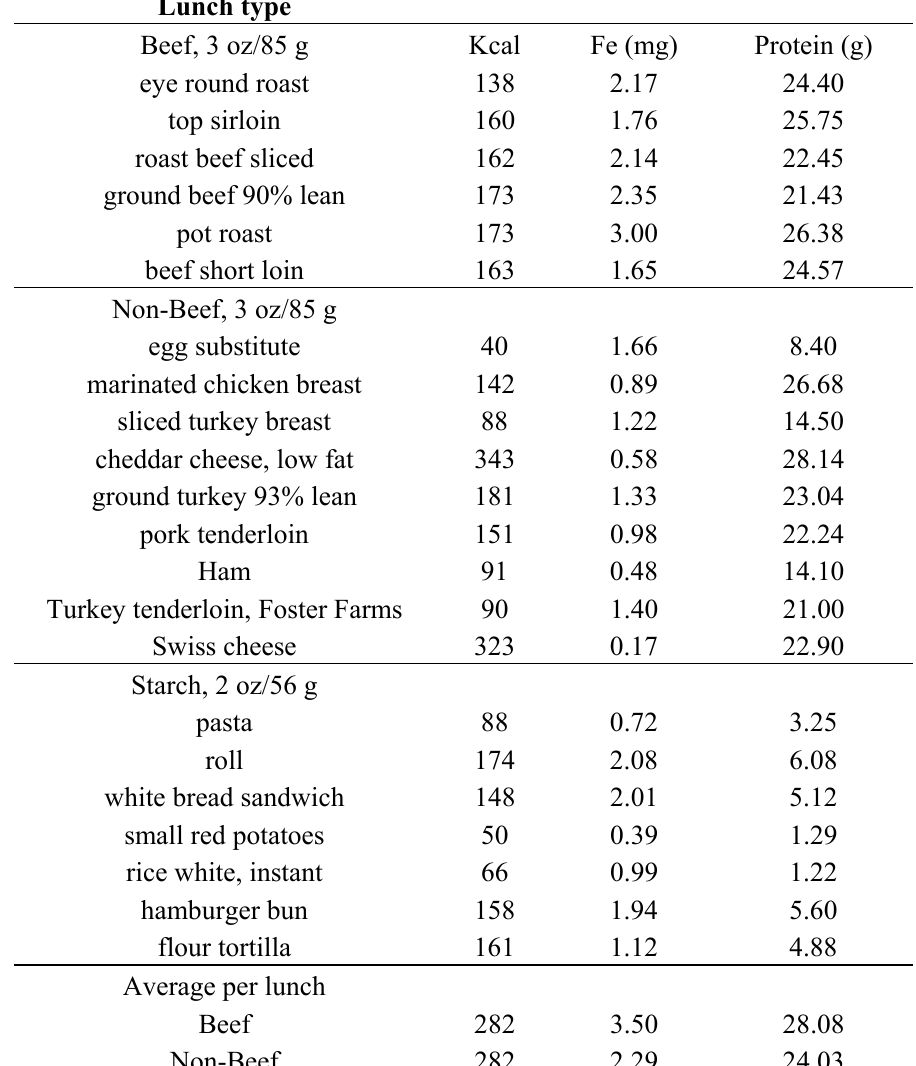
Table 1. Nutrition information for intervention lunches 1